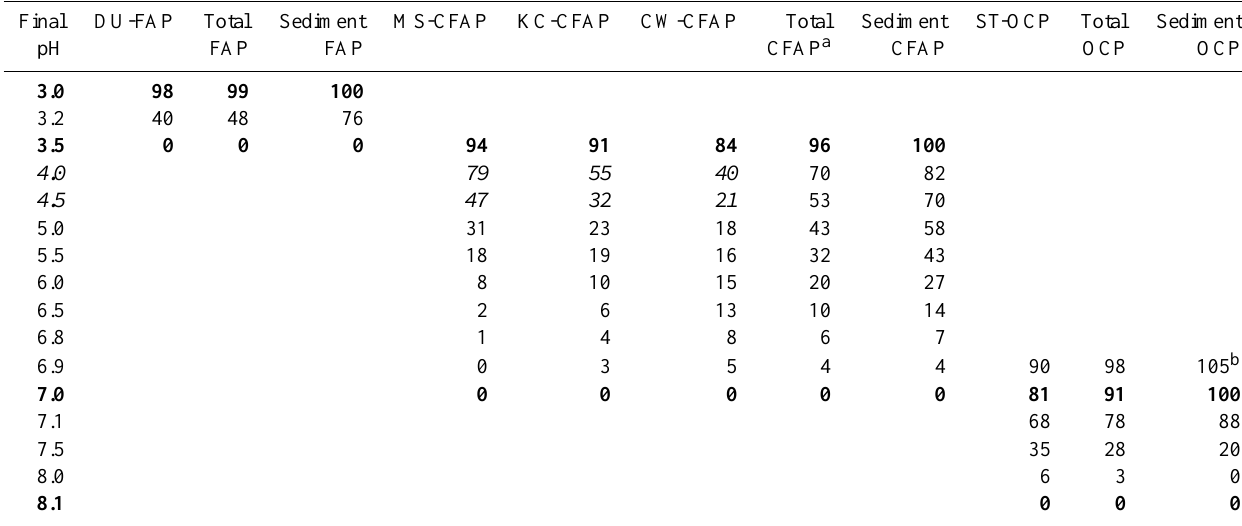
Table 2. Loss (%) of added reference species (FAP, CFAP, OCP), total species (added species plus corresponding sedimentary species) and sedimentary species (sediment FAP, CFAP, OCP) at varying pH as determined by the CONVEX method. See Table 1 for abbreviations of added standard